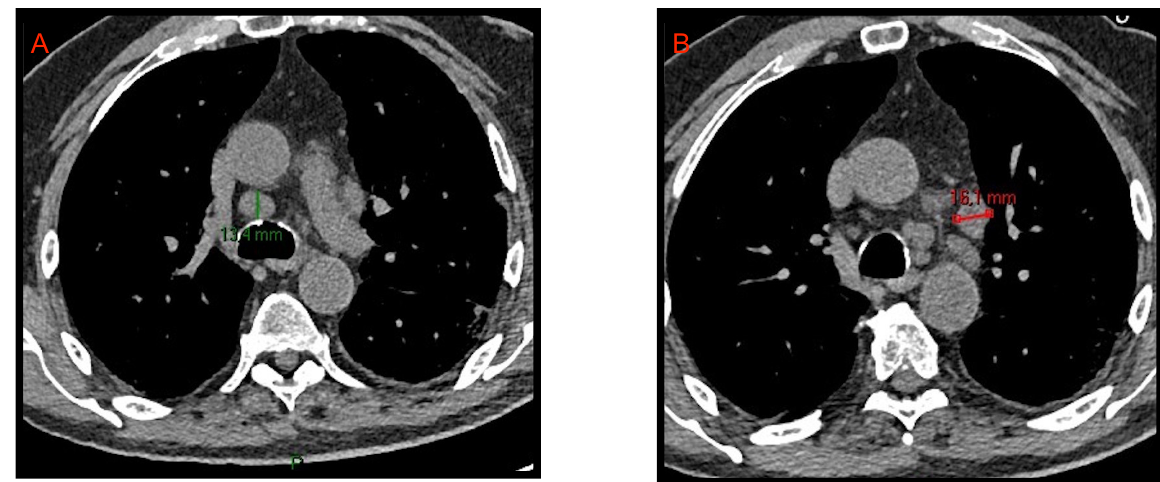
Figure 2. CT axial images of mediastinal lymphadenopathies . Enlarged lymph nodes with short axis of 13.4 mm and 16.1 mm are evident in the lower pre-tracheal space ( A ) and in the aorto-pulmonary window ( B ), respectively.